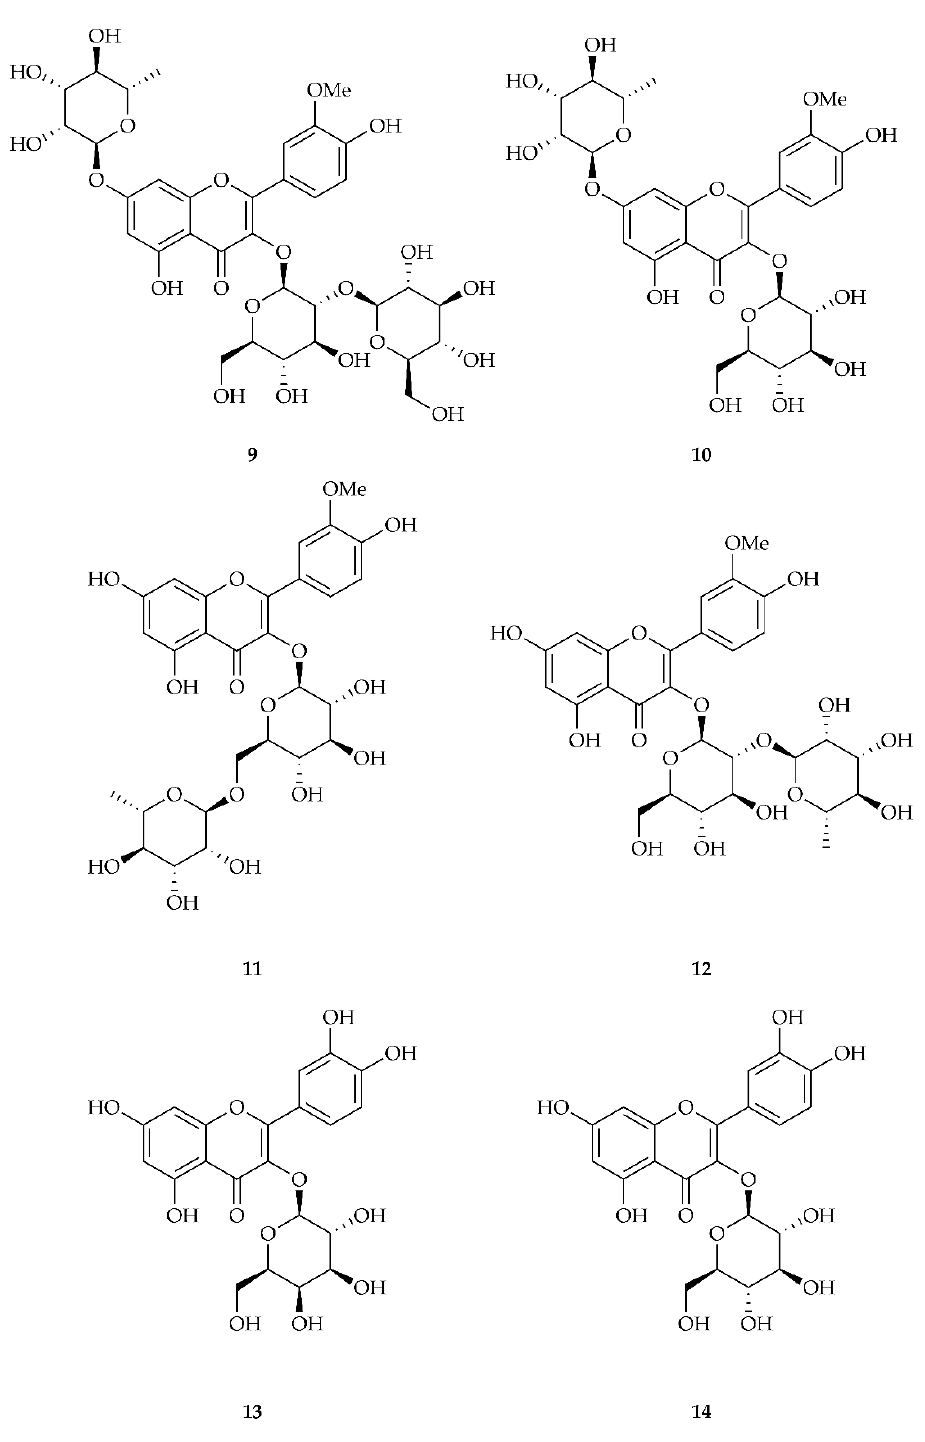
Figure 3. Structure of compounds isorhamnetin-3- O - sophoroside-7-rha 9 , isorhamnetin-3- O - glu-7- 10 , isorhamentin-3- O -rutinoside 11 , isorhamentin-3- O -neohesperoside 12 , quercetin-3- O -galactoside rha 10 , isorhamentin-3- O - rutinoside 11 , isorhamentin-3- O - neohesperoside 12 , quercetin-3- O - 13 , and quercetin-3- O -glucoside 14 galactoside 13 , and quercetin-3- O - glucoside 14.